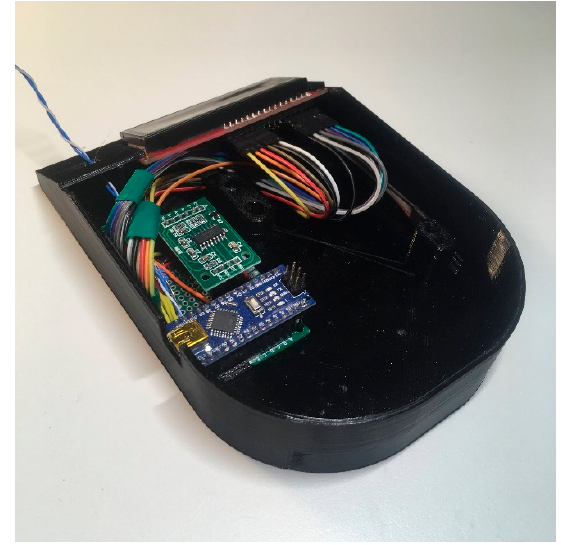
Figure 6. The LCD is held in place by two locators behind the slot for the screen. Its wires are tucked under a plastic wire manager attached to the TAL220 boss, then connected to the circuit board.